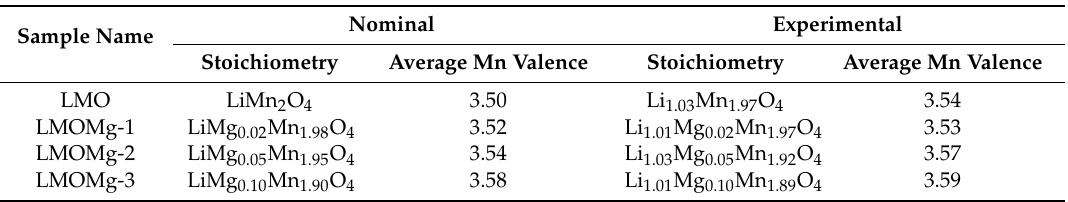
Table 5. LiMg x Mn 2 − x O 4 (x = 0.00, 0.02, 0.05, 0.10) chemical composition as determined by AAS and the average Mn